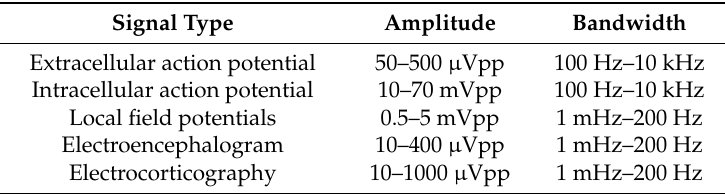
Table 1. Neural signal